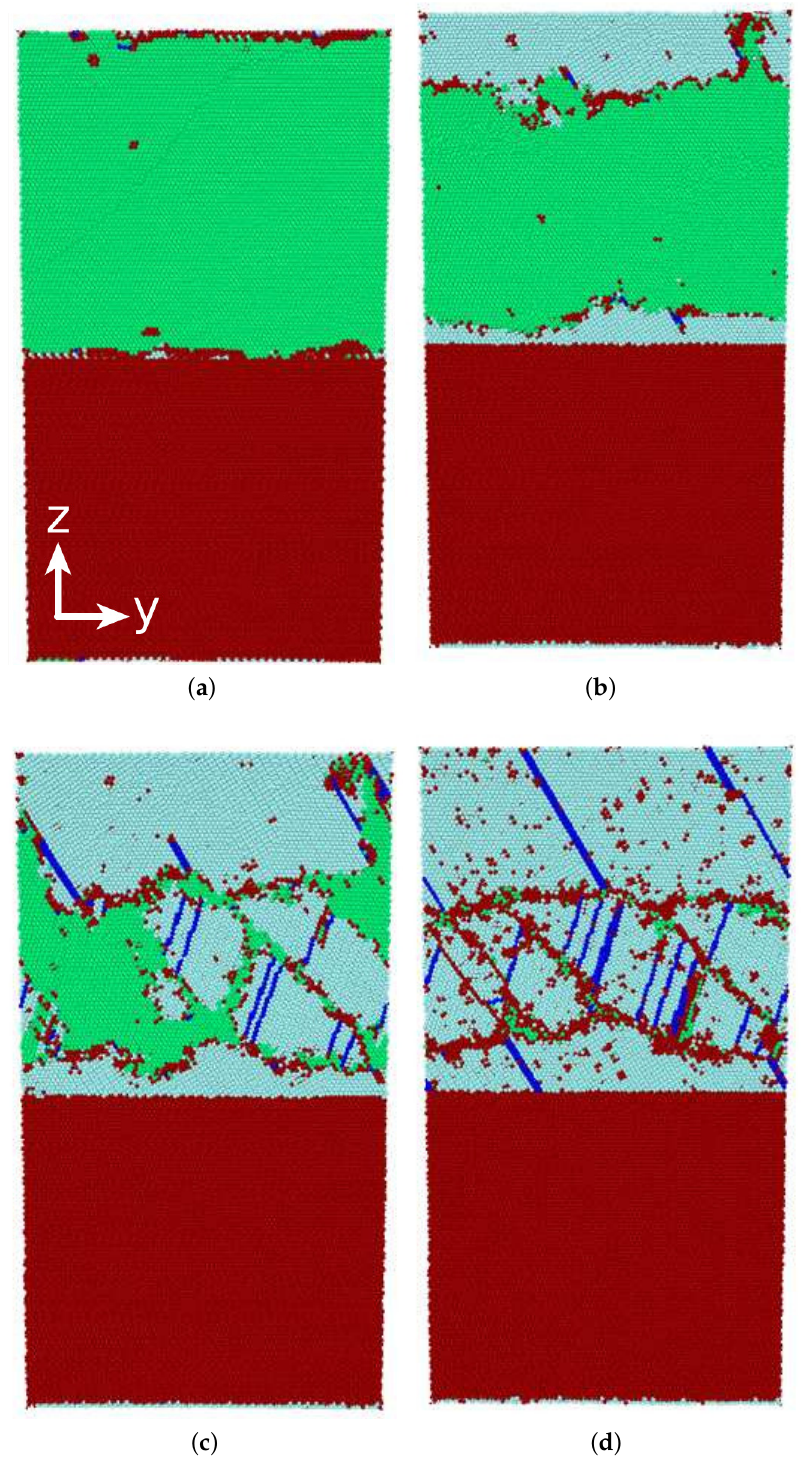
Figure 6. Cross-sectional views (in the z – y plane) of the transforming system during the austenitic transformation at: 1 K ( a ); 631 K ( b ); 671 K ( c ); and 1104 K ( d ). Atoms are colored as in Figure 2; in particular, the cementite crystallite is